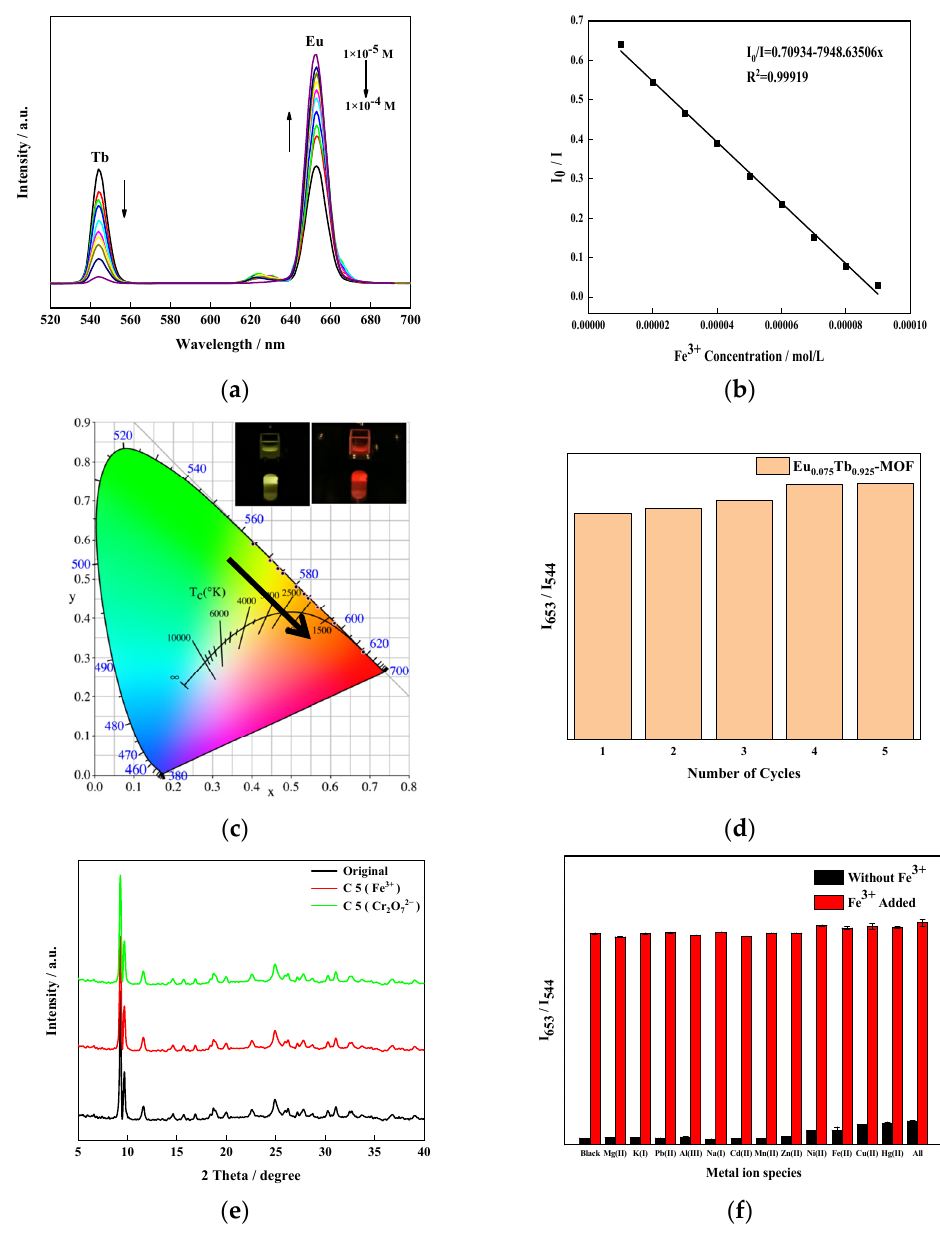
Figure 8. ( a ) The emission spectra of Eu 0.075 Tb 0.925 -MOF dispersions with different Fe 3+ concentra- tions under 310 nm excitation light. ( b ) Calibration line with Fe 3+ (in the range of 10–100 µ M/L), ( c ) CIE, ( d ) cycles of Eu 0.075 Tb 0.925 -MOF, ( e ) XRD pattern of Eu 0.075 Tb 0.925 -MOF after five cycles, and ( f ) I Eu /I Tb histogram of Eu 0.075 Tb 0.925 -MOF dispersion containing metallic cations. The fluorescence sensing selectivity of Eu 0.075 Tb 0.925 -MOF to Fe 3+ was investigated through the anti-interference experiment. The Eu 0.075 Tb 0.925 -MOF sample was immersed in NaX solution (Mg 2+ , K + , Pb 2+ , Al 3+ , Na + , Cd 2+ , Mn 2+ , Zn 2+ , Ni 2+ , Fe 2+ , Cu 2+ , Hg 2+ ) at a concentration of 1 × 10 − 4 M. The results are shown in Figure 8f. Except for Fe 3+ , the luminous intensity ratio of Eu 0.075 Tb 0.925 -MOF exhibits almost no change after the addition of metal ions. However, when the same amount of Fe 3+ was added to the Mg 2+ , K + , Pb 2+ , Al 3+ , Na + , Cd 2+ , Mn 2+ , Zn 2+ , Ni 2+ , Fe 2+ , Cu 2+ , and Hg 2+ solution containing Eu 0.075 Tb 0.925 - MOF, the luminous intensity ratio of I Eu /I Tb was significantly higher. This result shows that the sensing ability of Eu 0.075 Tb 0.925 -MOF on Fe 3+ will not be interfered with by